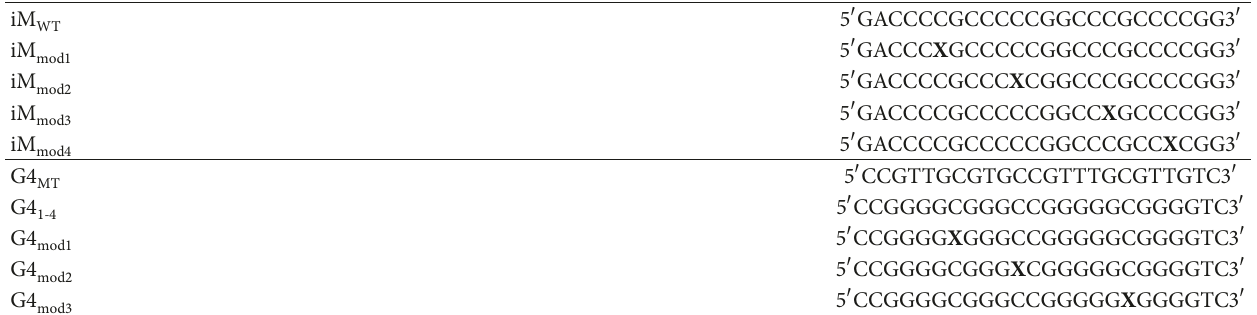
Table 1: The promoter sequence (24 mer) of the VEGF gene and its modifications for both G4/iM-forming regions. X denotes the 5- hydroxymethylated cytosine of each oligonucleotide